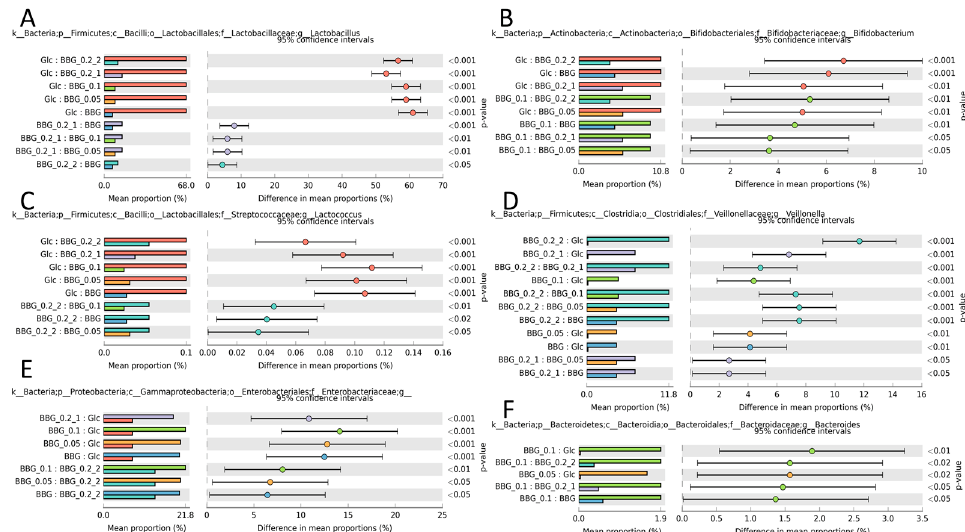
Figure 6. Significantly different taxa in genus level identified using ANOVA (Tukey HSD post-hoc test) with Benjamini-Hochberg FDR multiple test correction. ( A ) Lactobacillus ; ( B ) Bifidobacterium ; ( C ) Lactococcus ; ( D ) Veillonella ; ( E ) Enterobacteriaceae ; and ( F ) Bacteroides . These taxa were considered beneficial to the hosts.